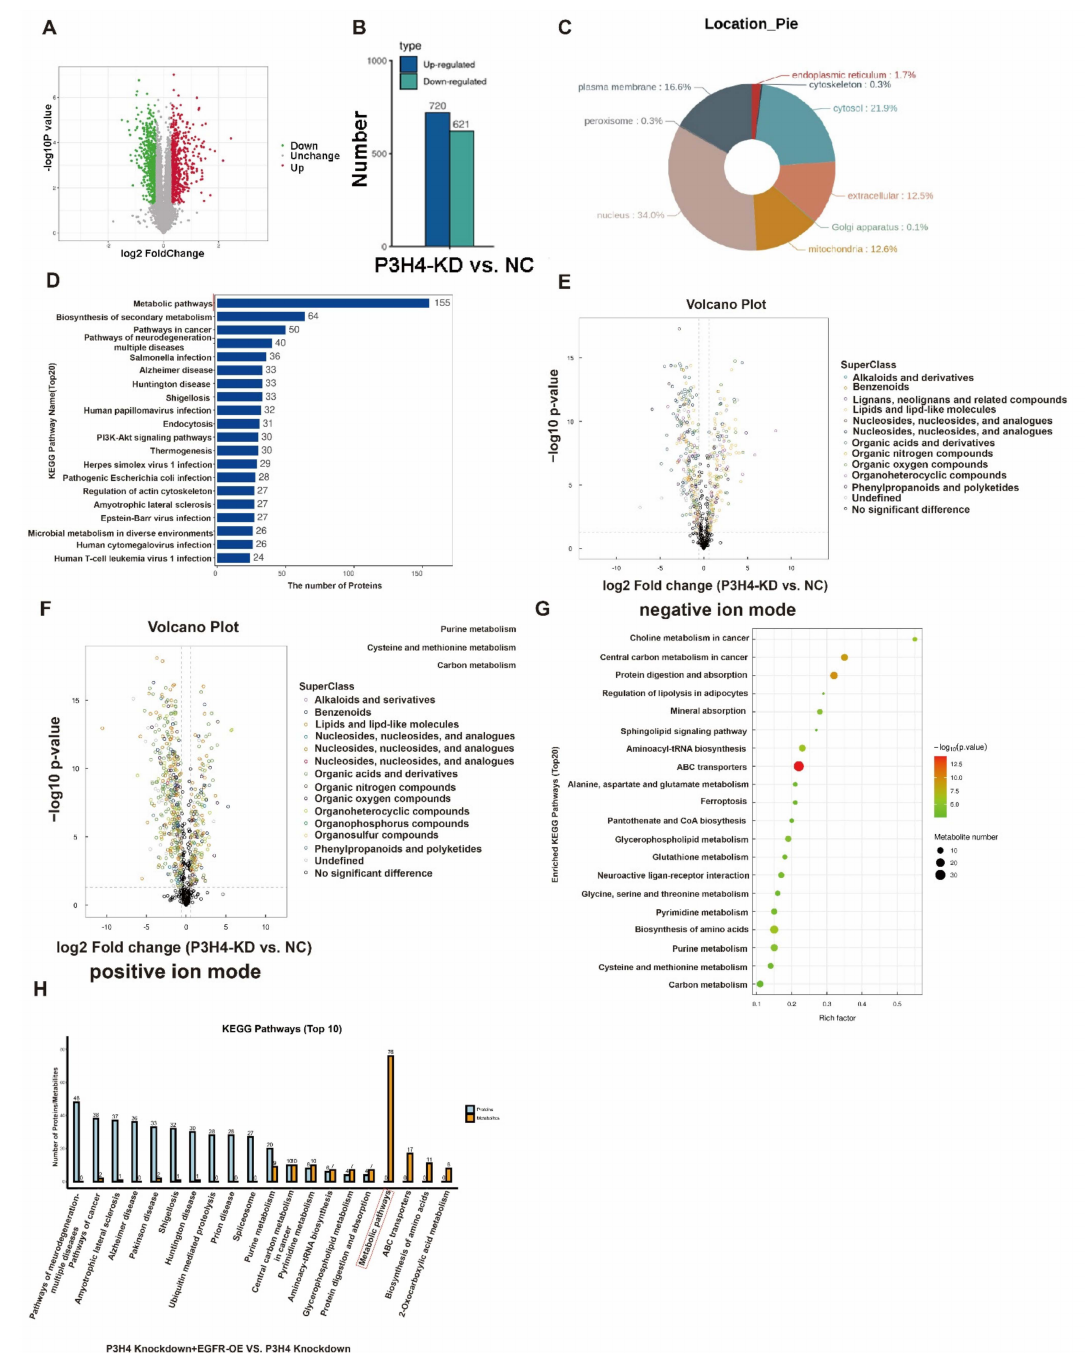
Figure 6. Pathway analysis of P3H4 downstream proteins. ( A ) Tandem Mass Tag (TMT) analysis of the differential expression of proteins following P3H4 knockdown. ( B ) Quantification of differential expression of proteins upon P3H4 knockdown. ( C ) The circular chart indicates the location of differentially expressed proteins. ( D ) Analysis of the KEGG pathway of P3H4-regulated proteins. ( E ) The differential expression of metabolic substances based on volcano plot using UHPLC-Q-TOF MS in negative ion mode. ( F ) The differential expression of metabolic substances based on the volcano plot using UHPLC-Q-TOF MS in positive ion mode. ( G ) Bioinformatics analysis of the KEGG pathway of differentially expressed metabolic substances following P3H4 knockdown. ( H ) Analysis of the KEGG pathway of comprehensively analyzed the proteomic and metabolomic data between P3H4 knockdown + EGFR-OE group and P3H4 knockdown